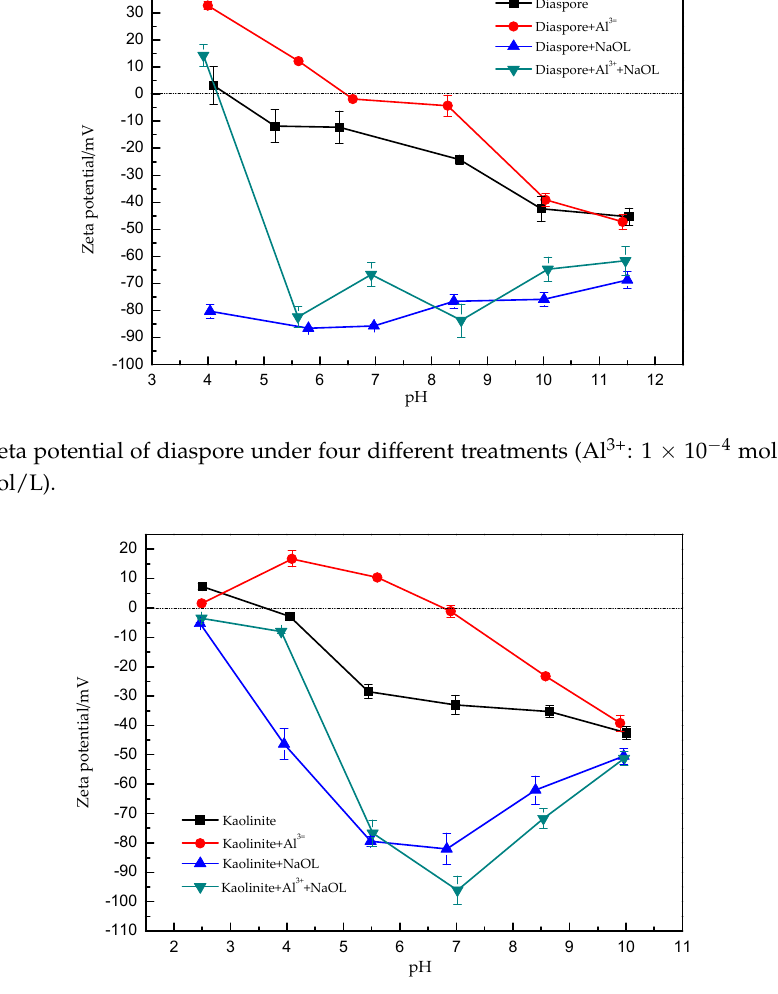
Figure 7. Zeta potential of kaolinite under four different treatments (Al 3+ : 1 × 10 − 4 mol/L; NaOL: 5 × 10 − 4 mol/L).